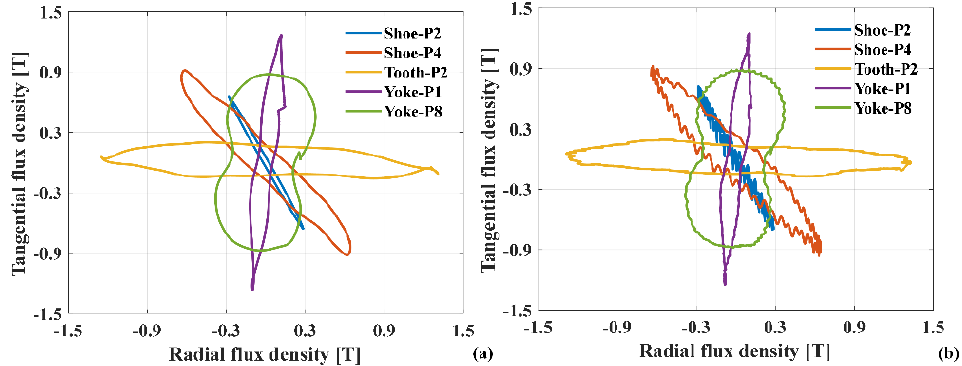
Figure 10. Elliptic loci of flux density in the normal and tangential directions: ( a ) sinusoidal and ( b ) PWM current applied to the stator winding.